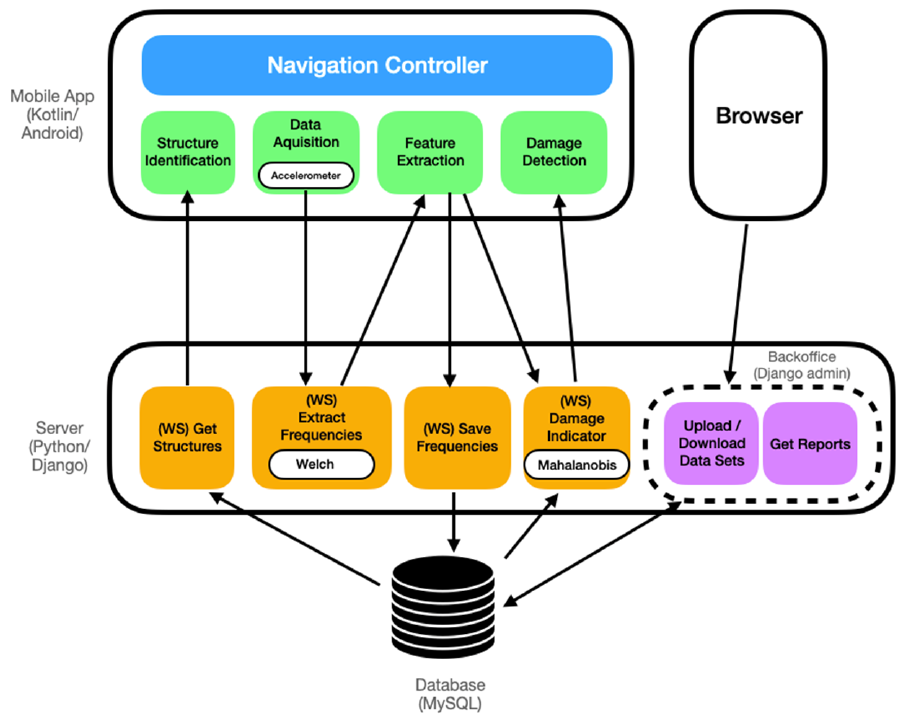
Figure 2. Architecture of App4SHM.